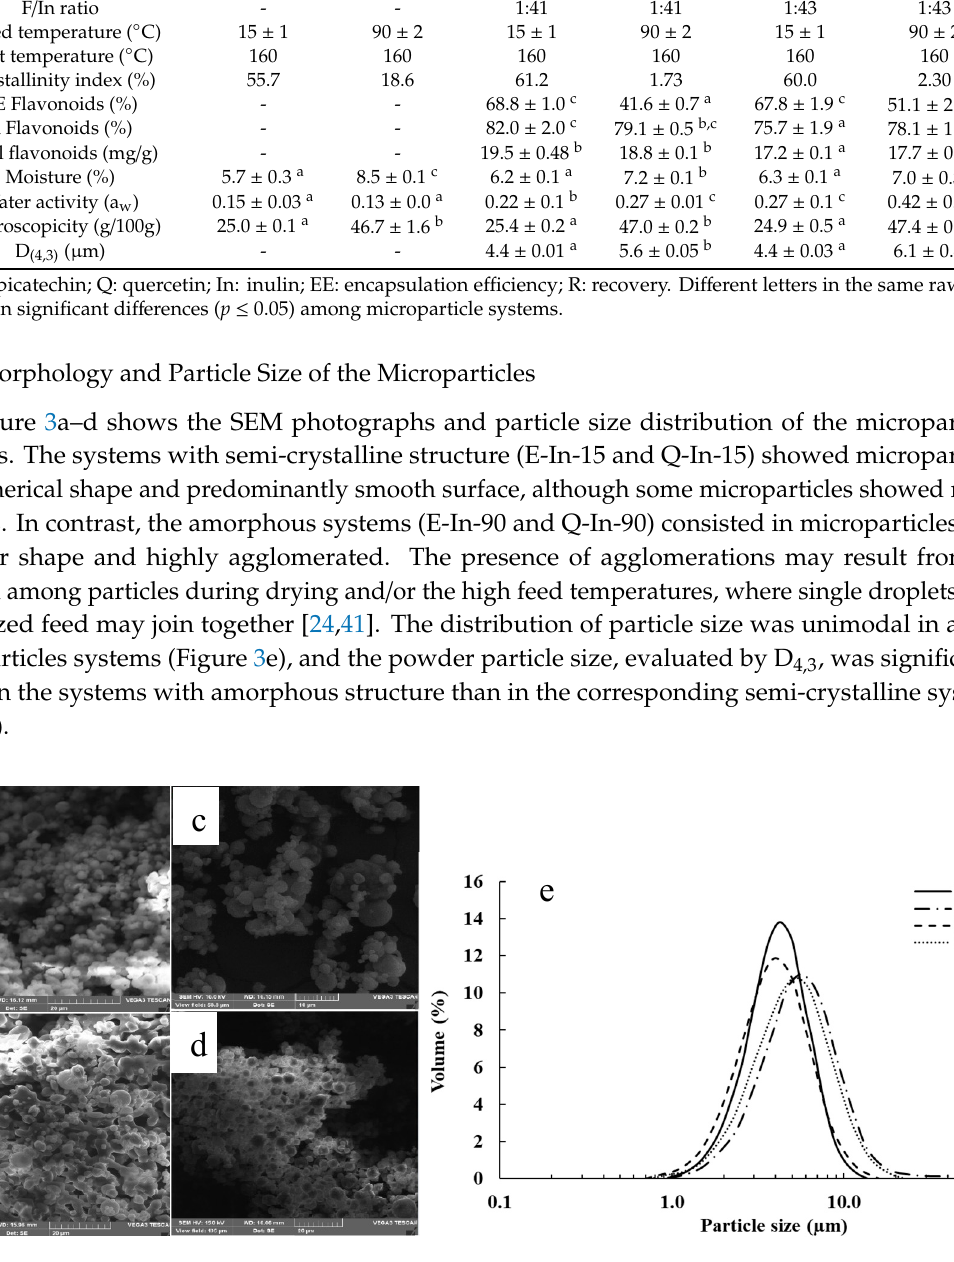
Table 2. Induction period (IP) and protection factor (PF) for methyl linoleate (ML) and sunflower oil (SO) with and without amorphous or semi-crystalline flavonoid microparticles (200 mg/kg ML or SO).